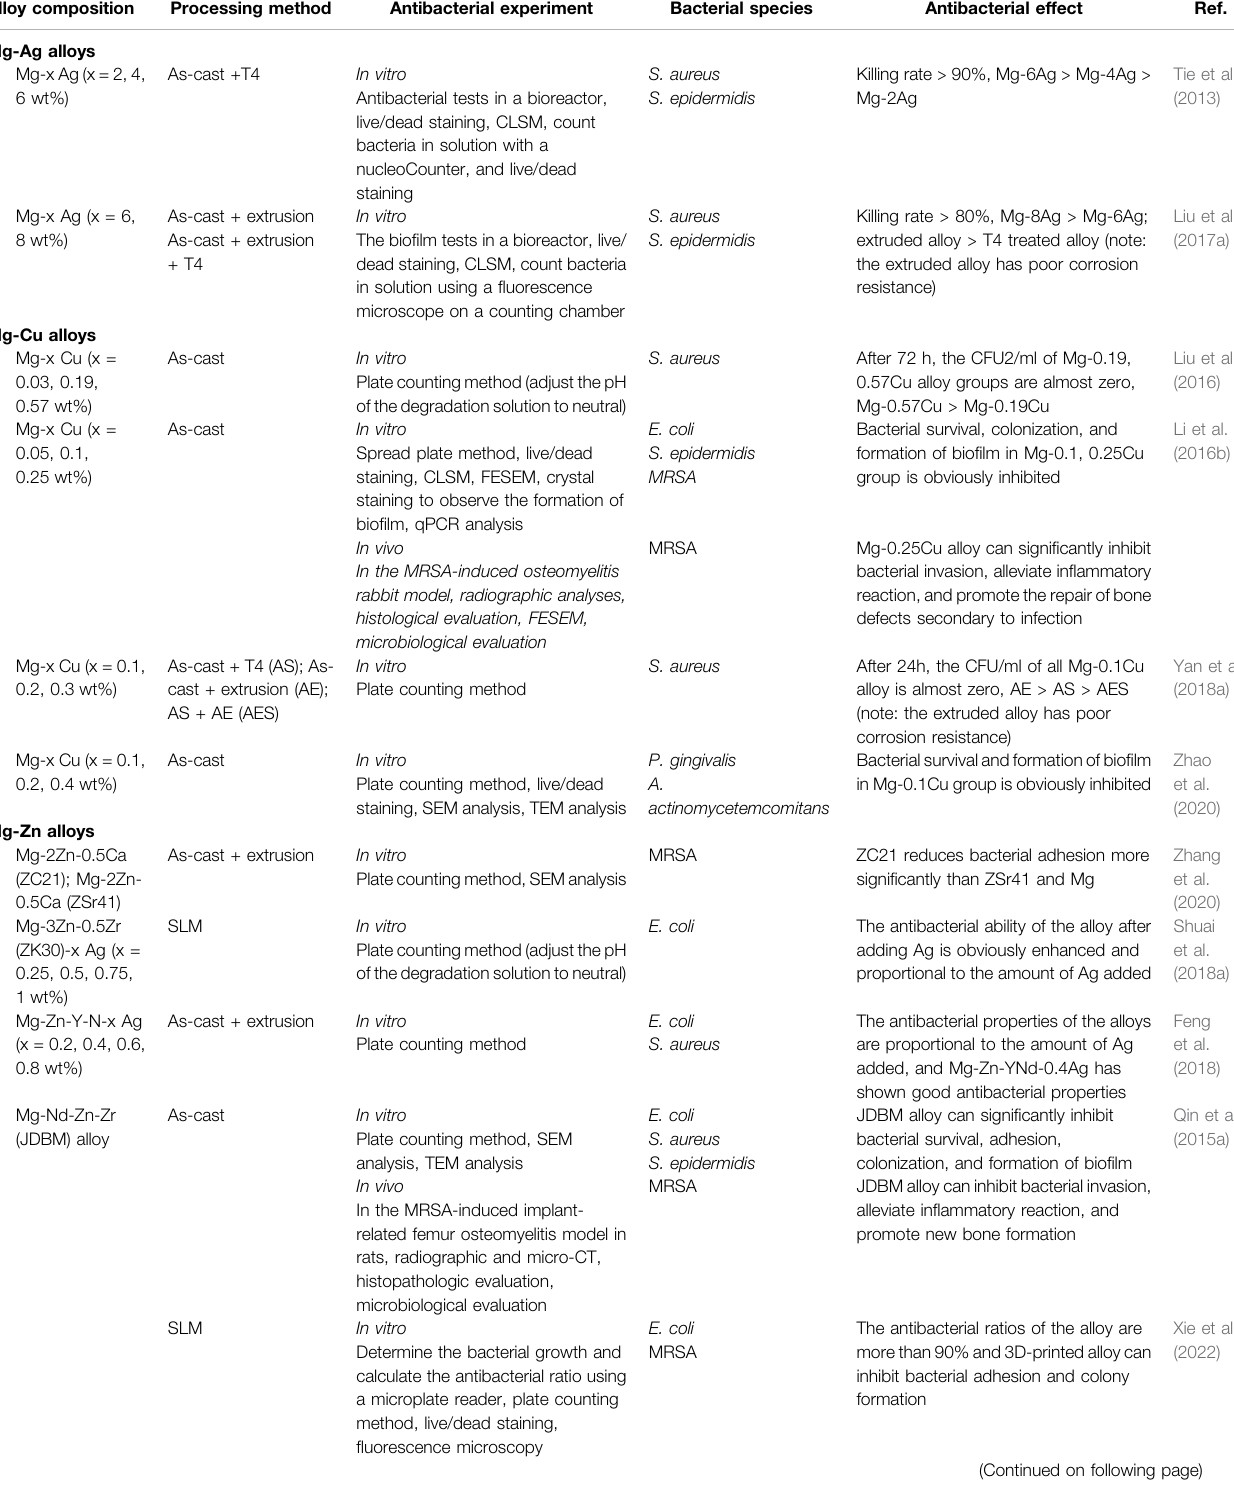
TABLE 1 | Antibacterial properties of Mg-based alloys with antibacterial properties as orthopedic implants. Alloy